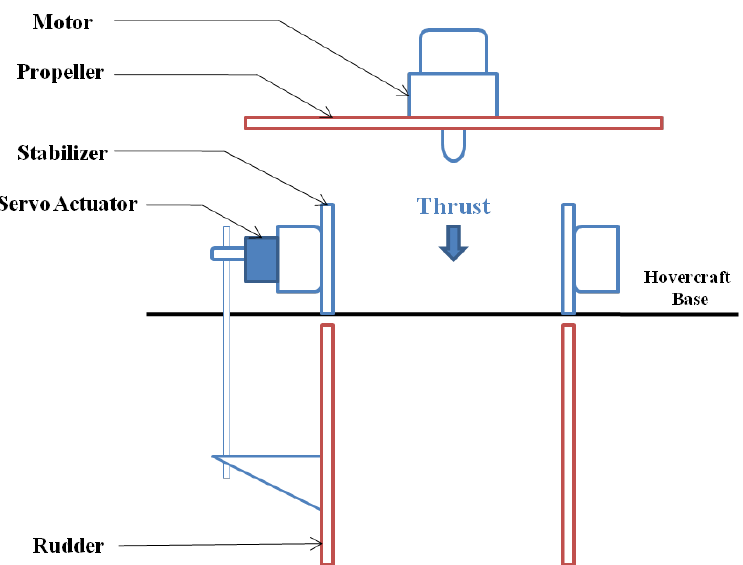
Figure 14. Forward thrust and actuation system